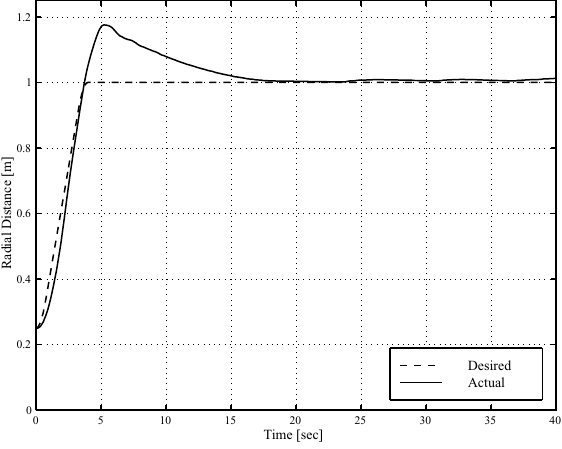
Fig. 23. Desired and actual radial distances for the compound case using the fuzzy controller.